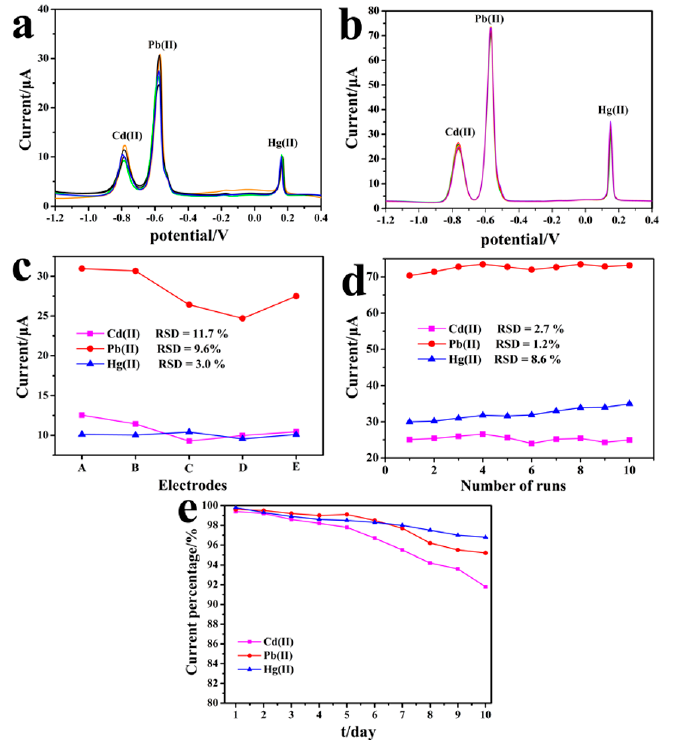
Figure 11. DPV response of 1.0 μ M Cd(II), Pb(II), and Hg(II) at PProDOT(MeSH) 2 @Si/GCE for the ( a ) reproducibility and ( b ) repeatability. The peak current value change ( c ) and ( d ) corresponding to ( a ) and ( b ), (e) Stability curves PProDOT(MeSH) 2 @Si/GCE. RSD refers to the relative standard deviation.